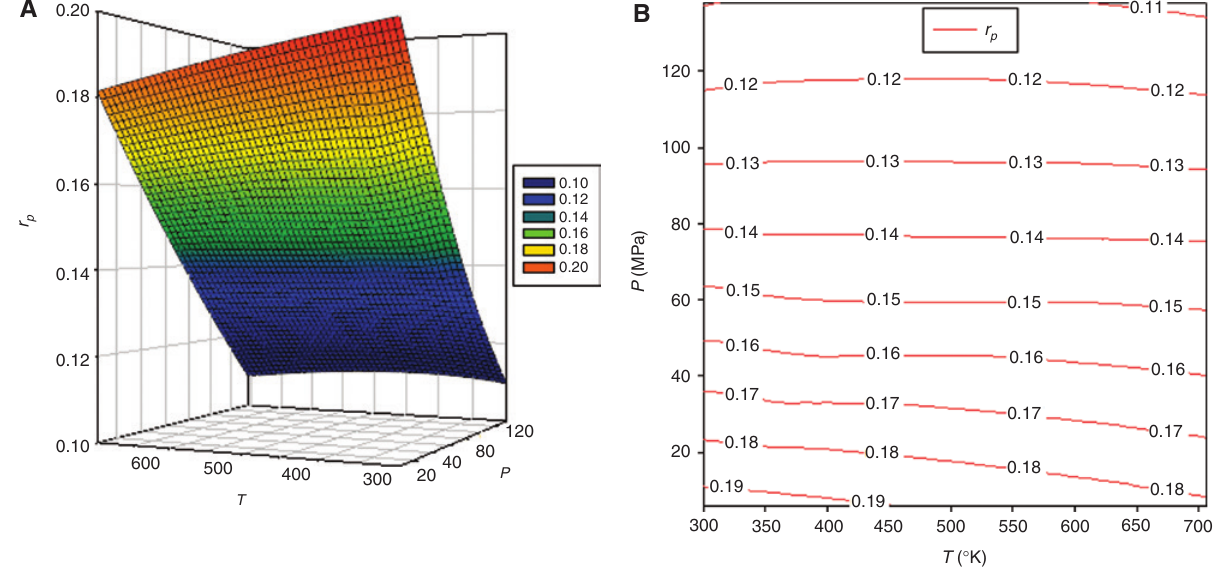
Figure 7: Boundary radius of elasto-plastic zones for different values of the combined pressure and temperature loadings (A) three-dimen- sional mesh and (B) contour